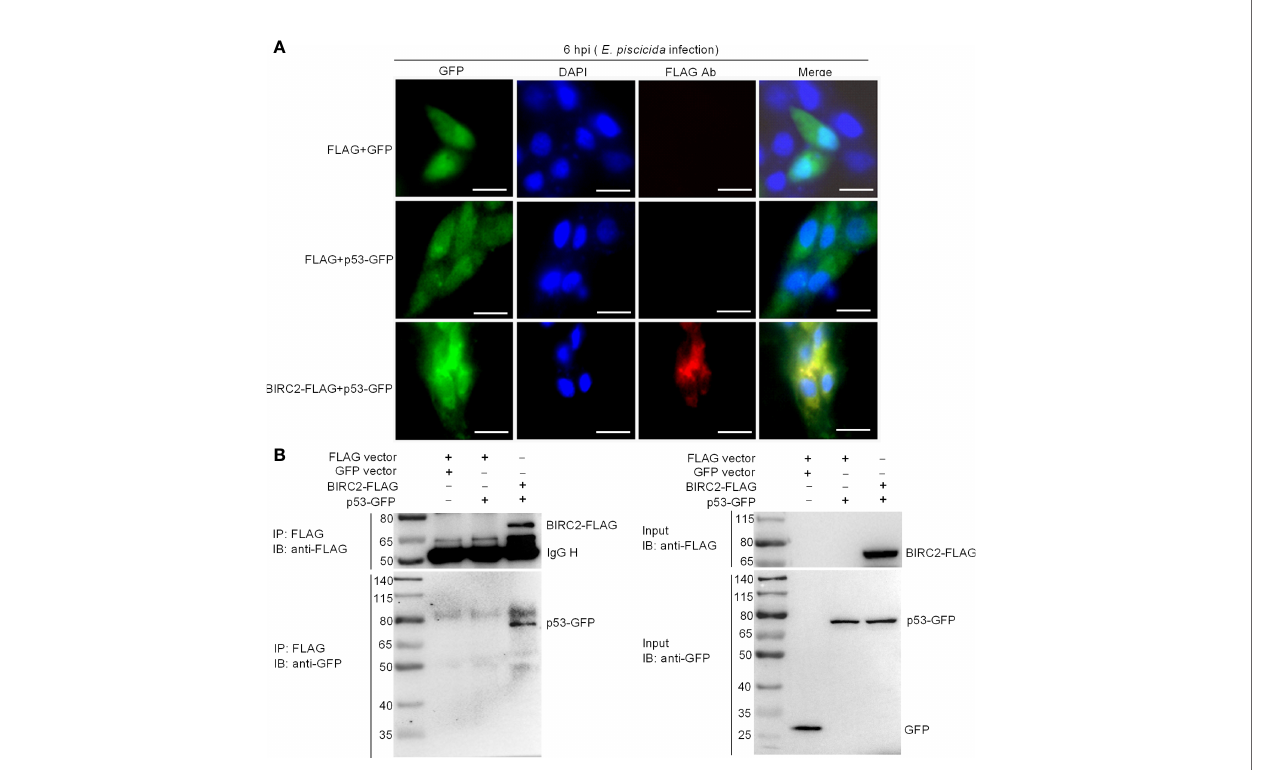
FIGURE 7 | Zebra fi sh BIRC2 colocalizes and interacts with p53. (A) Immuno fl uorescence analysis of zebra fi sh BIRC2 and p53 in EPC cells. EPC cells were transfected with the indicated plasmids and then infected with E. piscicida . At 6 hpi, the infected cells were fi xed with 4% formaldehyde for 15 min and subjected to immuno fl uorescence microscopy assays. Scale bar: 10 m m. (B) The interaction between zebra fi sh BIRC2 and p53. EPC cells were transfected with the indicated plasmids, then lysed and immunoprecipitated using Anti-FLAG M2-Agarose Af fi nity Gel beads. The input proteins and precipitates were subjected to Western Blotting using anti-FLAG and anti-pTurboGFP